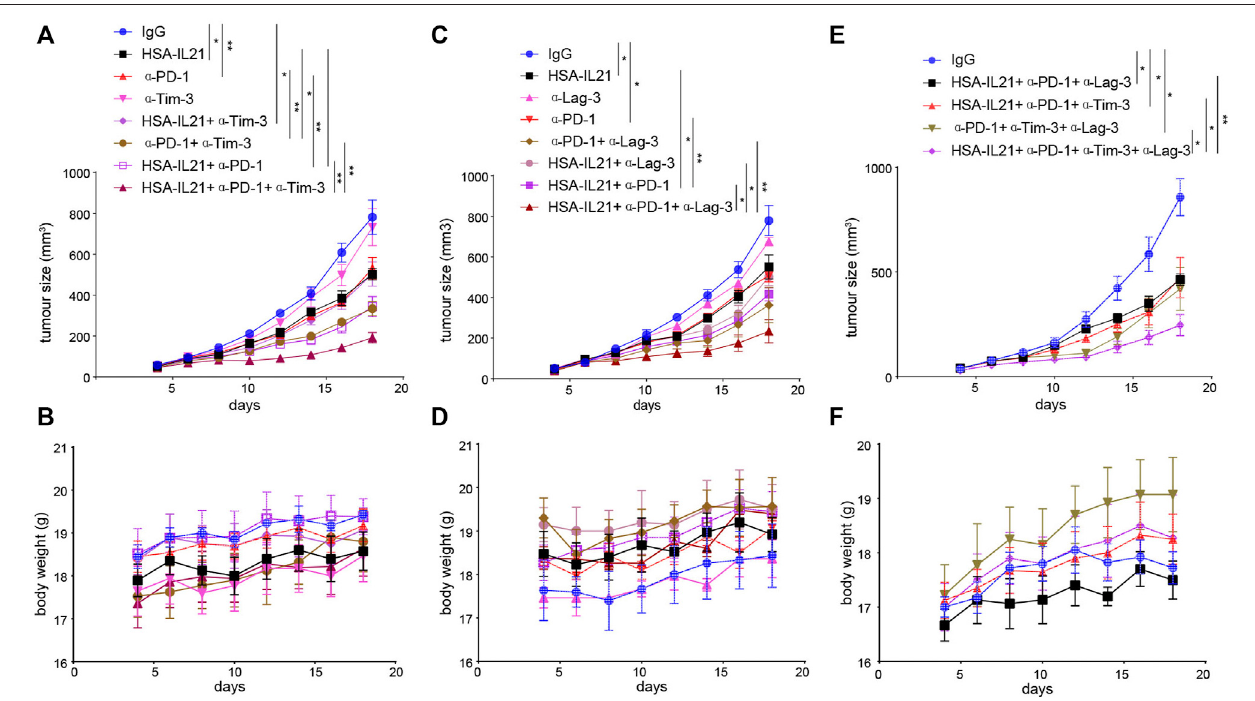
FIGURE 8 | HSA-IL21 combined with Tim-3, Lag-3, and PD-1 blockade additively inhibits tumor growth. (A,B) MC38 tumor cells (1 × 10 6 ) were injected intradermally to B6 mice, 5 days after tumor inoculation, MC38 tumor-bearing mice were treated with IgG, HSA-IL21, α -PD-1, α -Tim-3, HSA-IL21/ α -PD-1, HSA-IL21/ α -Tim-3, α -PD-1/ α -Tim-3,HSA-IL21/ α -PD-1/ α -Tim-3,fortotal4times.Tumorsize (A) andbodyweight (B) weremeasuredevery2 days.( n (cid:2) 4 – 5).Datawerepresented as mean ± SEM, n (cid:2) 5, *p < 0.05, ** p < 0.01, *** p < 0.001, **** p < 0.0001, two-way ANOVA test was performed. (C,D) MC38 tumor cells (1 × 10 6 ) were injected intradermally to B6 mice, 5 days after tumor inoculation, MC38 tumor-bearing mice were treated with IgG, HSA-IL21, α -PD-1, α -Lag-3, HSA-IL21/ α -PD-1, HSA-IL21/ α -Lag-3, α -PD-1/ α -Lag-3,HSA-IL21/ α -PD-1/ α -Lag-3, fortotal 4times. Tumorsize(C) and body weight(D)were measured every2 days. ( n (cid:2) 3 – 5).Datawerepresented as mean ± SEM, n (cid:2) 5, *p < 0.05, ** p < 0.01, *** p < 0.001, **** p < 0.0001, two-way ANOVA test were performed. (E – F) MC38 tumor cells (1 × 10 6 ) were injected intradermally to B6 mice, 5 days after tumor inoculation, MC38 tumor-bearing mice were treated with IgG, HSA-IL21/ α -PD-1/ α -Tim-3, HSA-IL21/ α -PD-1/ α -Lag-3, α -PD-1/ α -Tim-3/ α -Lag-3, HSA-IL21/ α -PD-1/ α -Tim-3/ α -Lag-3, for total 4 times. Tumor size (E) and body weight (F) were measured every 2 days. ( n (cid:2) 3 – 5). Data were presented as mean ± SEM, n (cid:2) 5, *p < 0.05, ** p < 0.01, *** p < 0.001, **** p < 0.0001, two-way ANOVA test was